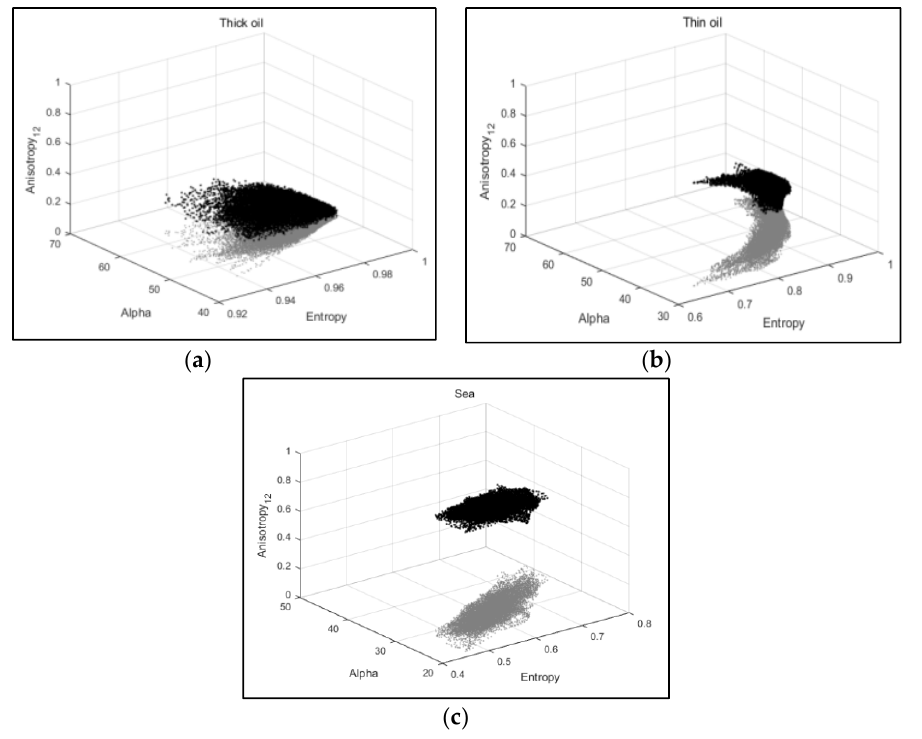
Figure 10. H /α/ A 12 plots for slick and seawater in Case 1. The gray scatter points indicate the H/α plane; ( a – c ) correspond to the thick oil sample, the thin oil sample, and the clean seawater sample, respectively.